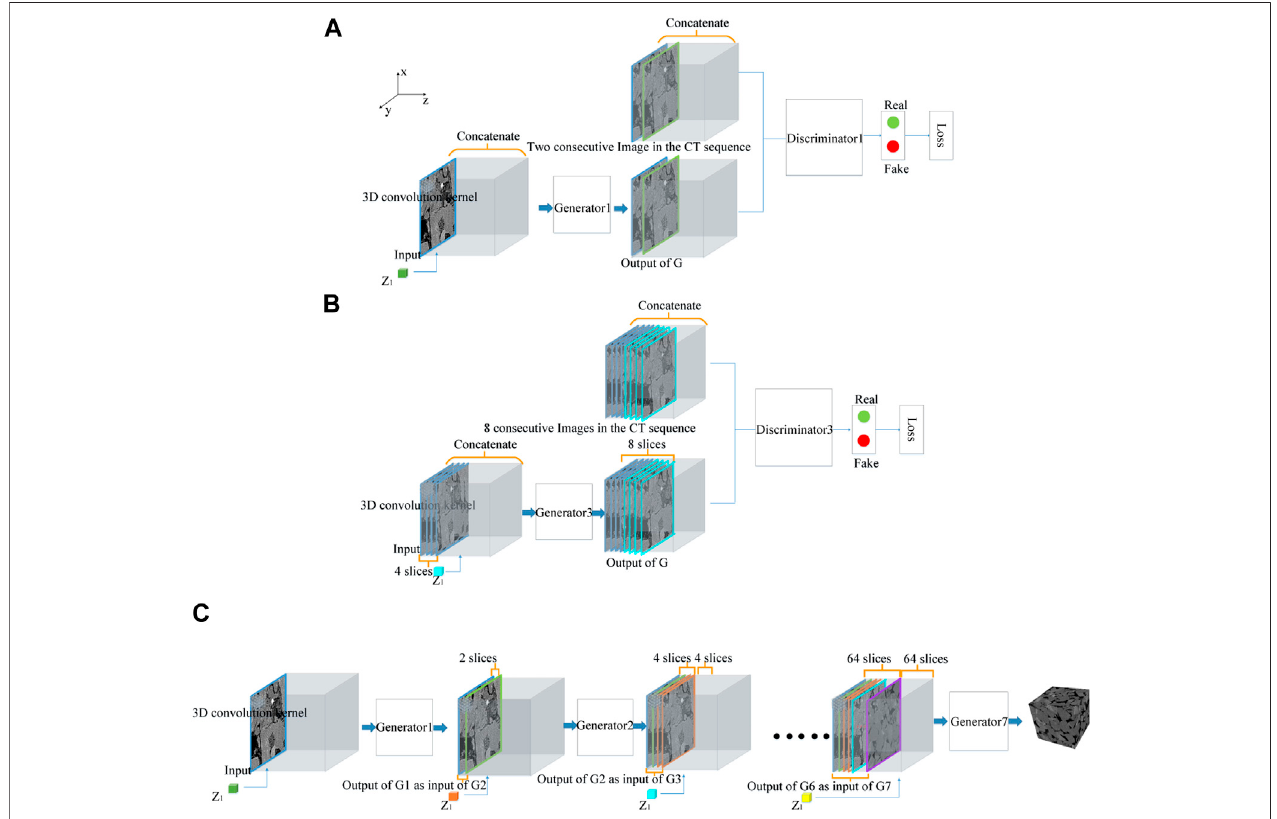
FIGURE 2 | Schematic diagram for the training and reconstruction stage of CPGAN. (A) The fi rst node networks in the training process of CPGAN; (B). The third node networks in the training process of CPGAN; (C) The reconstruction stage of CPGAN.